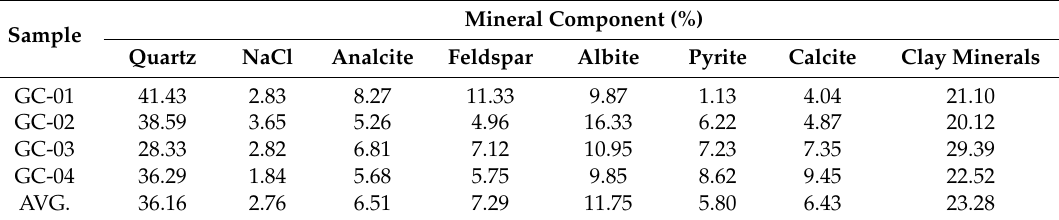
Table 5. Mineral components of cap rock determined by